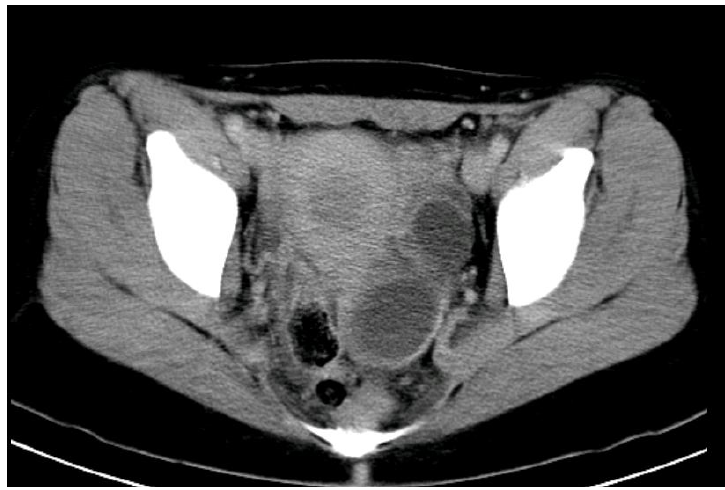
FIGURE 2. Computed tomography exhibiting an oval cystic mass of approximately 16  6 cm in the left retrovesical space adjacent to the bladder. The wall of the masses exhibited a contrast medium encasement.